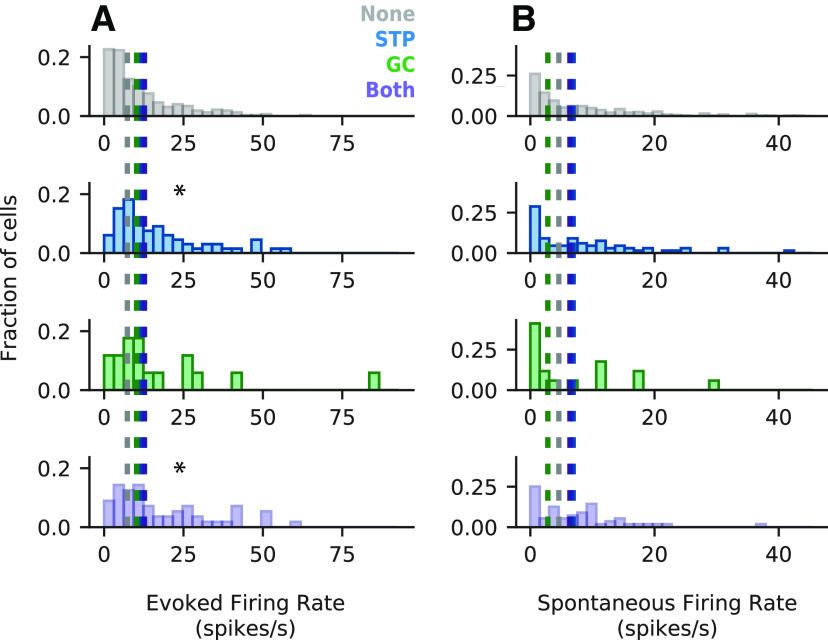
Mean evoked and spontaneous firing rates grouped by nonlinear model performance. A, Histograms of mean evoked firing rate for four mutually exclusive groups of neurons: no significant improvement in prediction accuracy for the nonlinear models (gray, top), significant improvement for the STP model relative to the LN model (blue, middle-top), significant improvement for the GC model relative to the LN model (green, middle-bottom), or significant improvement for both the STP and GC models or the GC+STP model (purple, bottom). Median evoked firing rate was significantly higher for the STP (11.7 spikes/s) and Both (12.7 spikes/s) groups than for the None group (7.31 spikes/s, Mann–Whitney U test, *p = 1.68 × 10−3 and *p = 2.67 × 10−3, respectively, adjusted for multiple comparisons). All other comparisons were not statistically significant (p > 0.05). B, Histograms of spontaneous firing rate for each model, plotted as in A. None of the groups was significantly different from the others (p > 0.05).